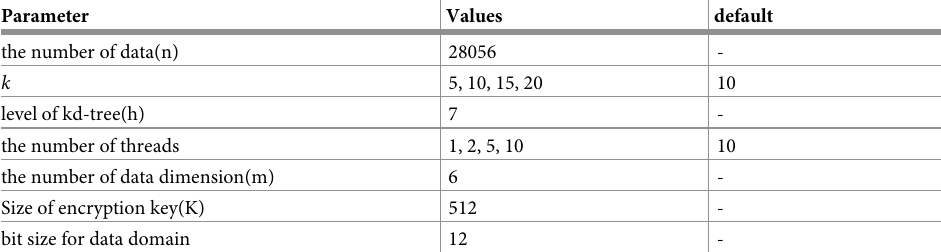
Table 5. Parameters used in performance evaluation for real data.